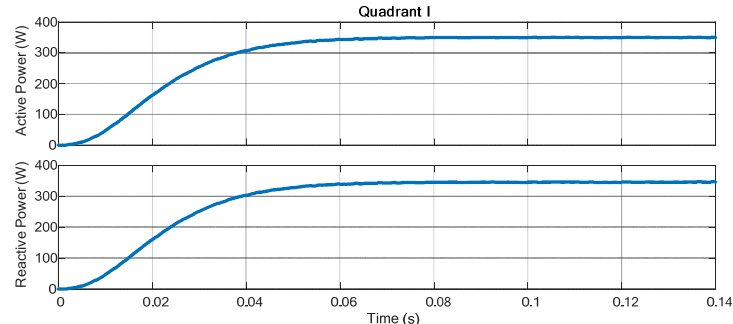
Figure 8. Instantaneous measurements: web interface.